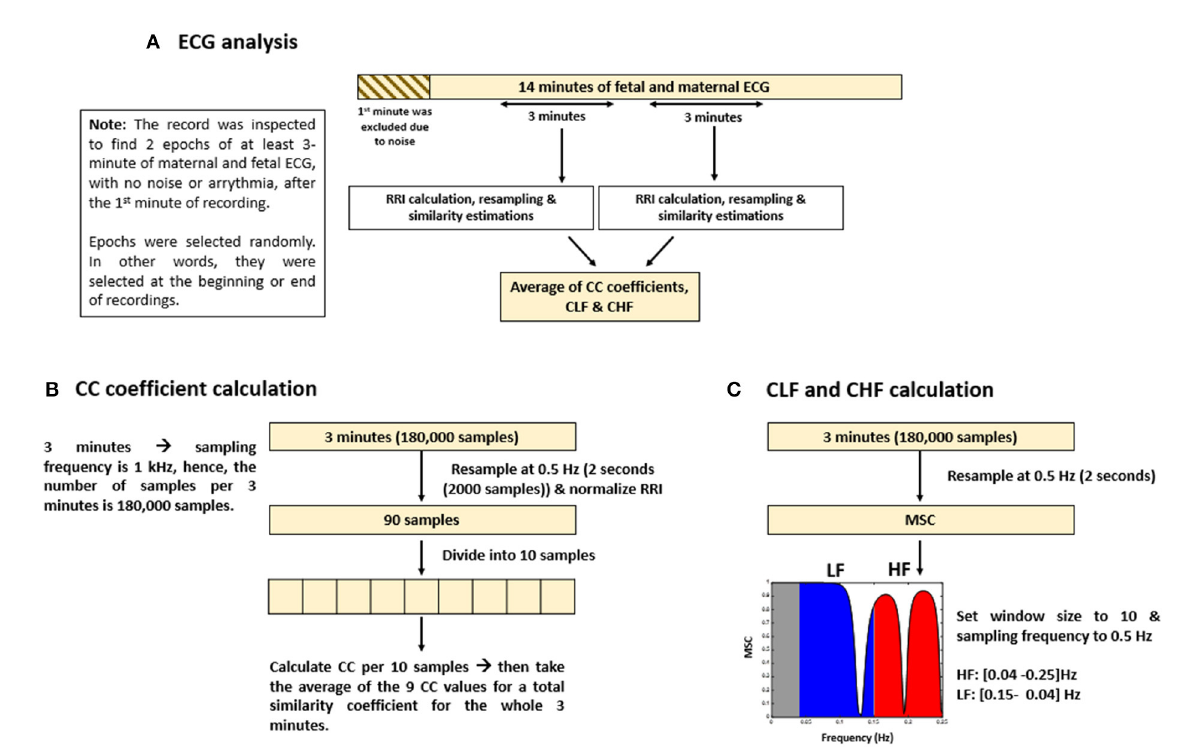
FIGURE1 Summary of electrocardiogram (ECG) analysis and similarity estimations. The figure provides (A) an illustrative summary of the protocols that were followed to analyze ECG data, (B) calculation of cross correlation (CC) coefficients, and (C) coherence low frequency (CLF) and coherence high frequency (CHF)